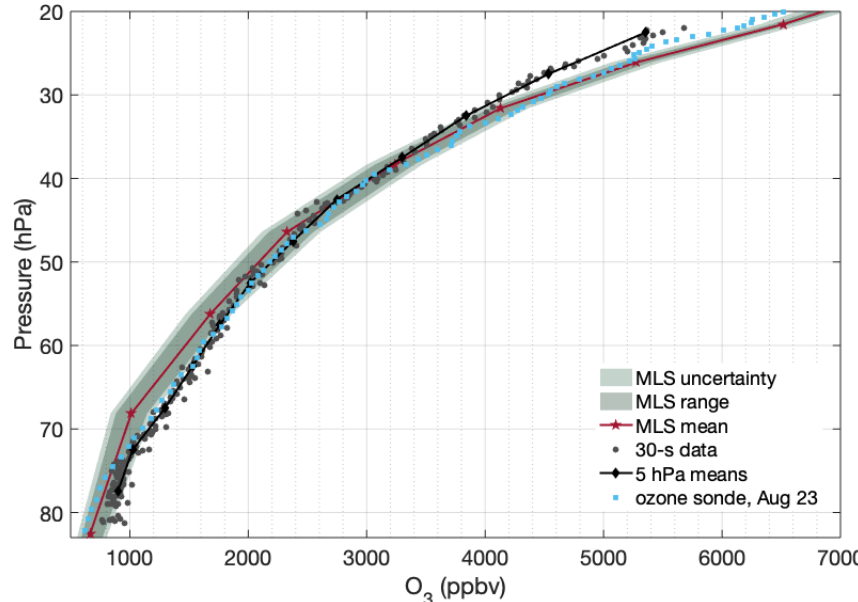
Figure 12. Ozone profile from HUSCE (grey circles) overlaid onto 11 MLS observations in the same way as in Fig. 10. The 11 MLS observations are at the same locations as those shown in Fig. 11. The light blue circles are observations from a NOAA ozone sonde in Boulder, CO, on the evening of 23 August 2018.